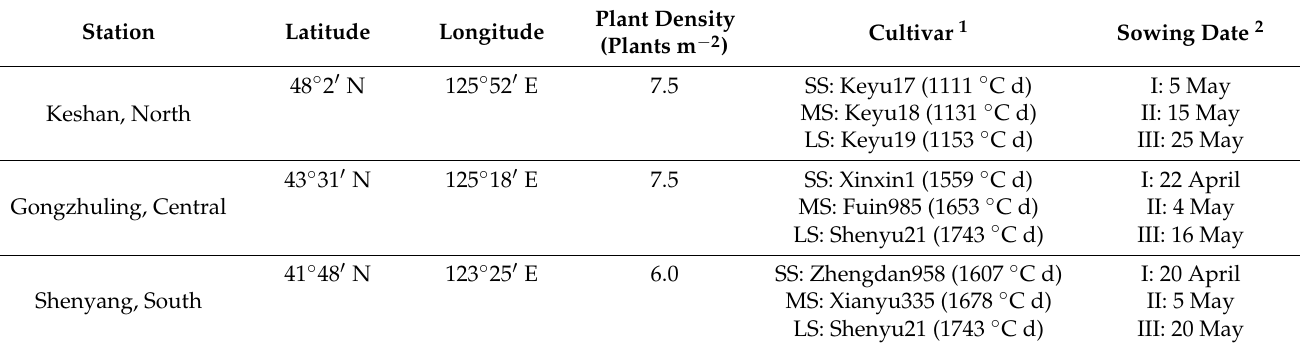
Table 2. Details of field experiments at each experimental